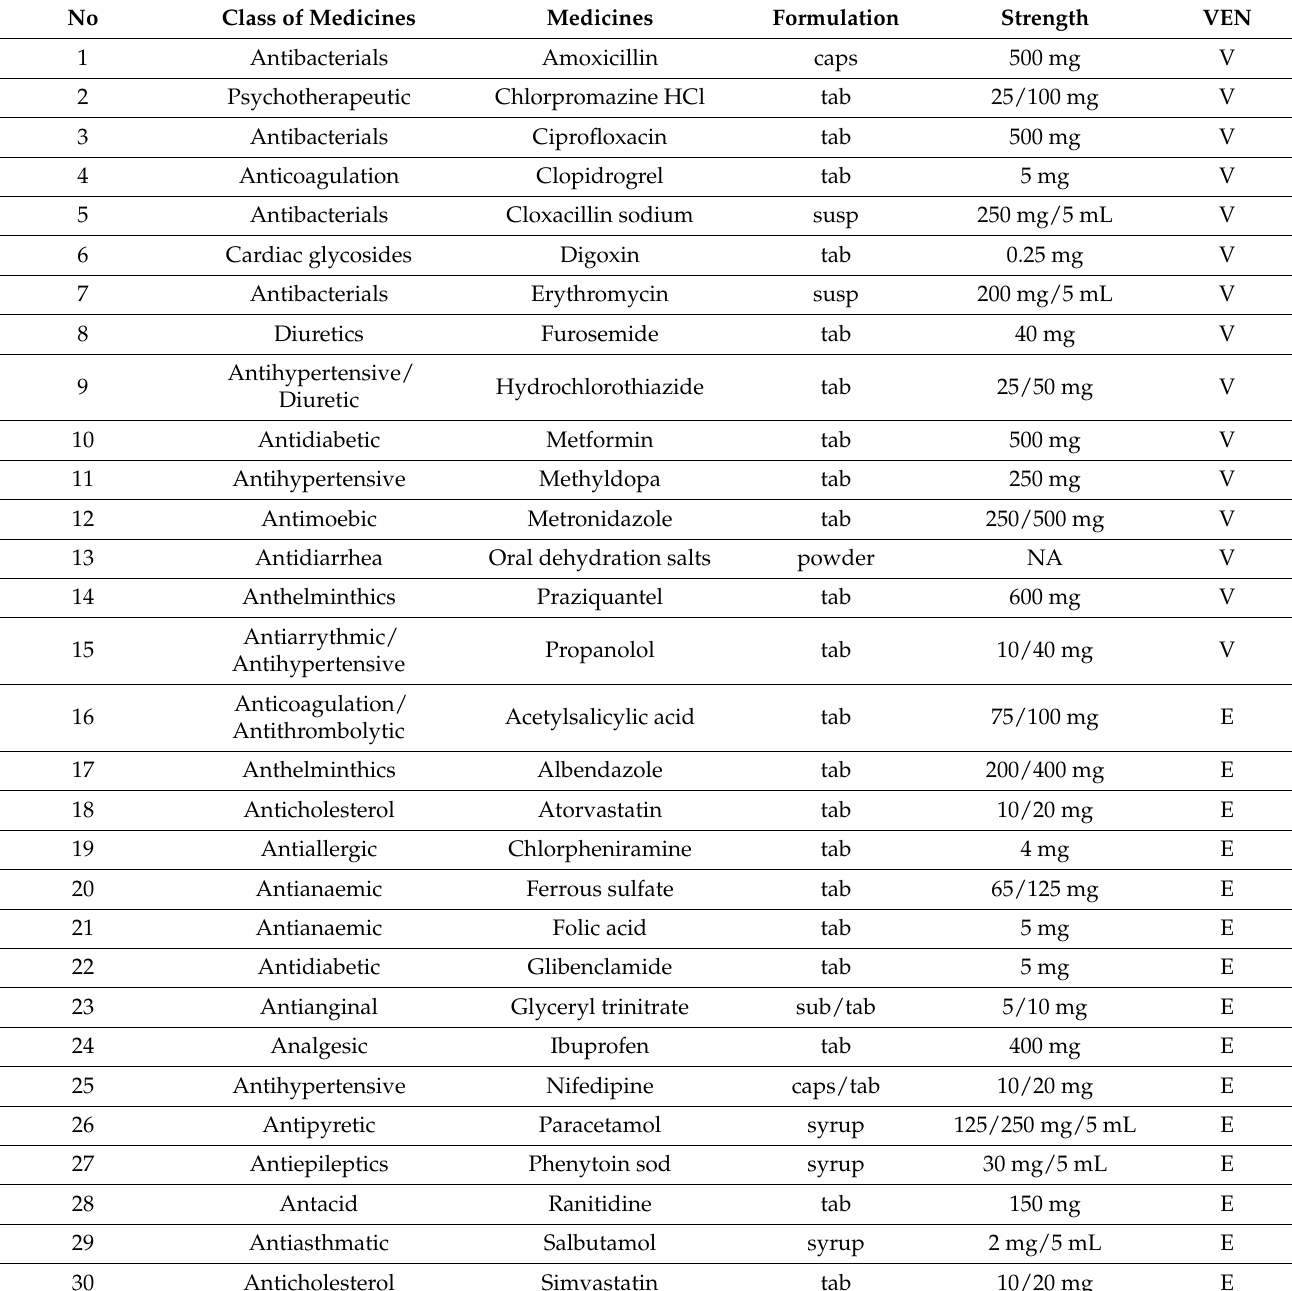
Table 2. List of essential medicines included in the